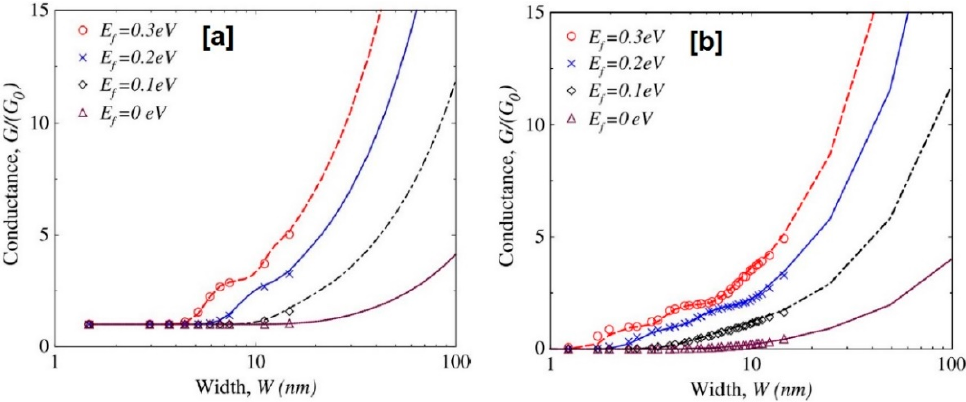
Figure 9. Conductance of ( a ) metallic armchair GNRs and ( b ) semiconducting armchair GNRs as function of width ( w ) of graphene nanoribbons [5]. Reproduced with permission from [5]. IEEE, 2009.